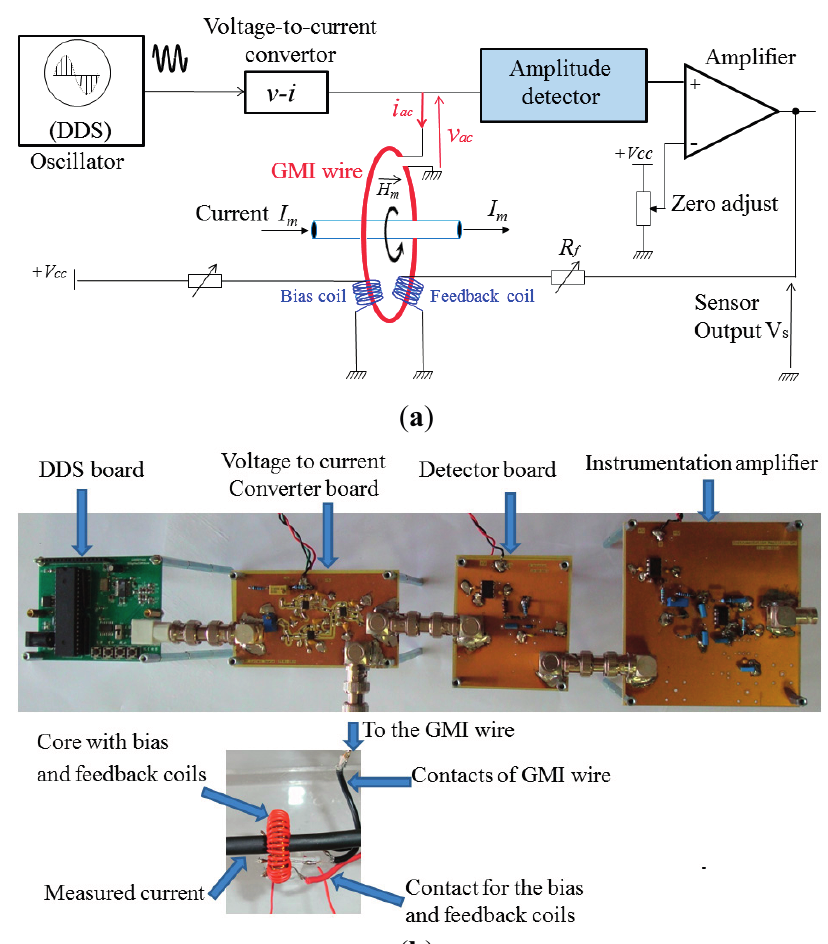
Figure 13. Block diagram of the GMI sensor for the measurement of magnetic fields ( a ) and photo of the setup ( b ). The GMI wire was biased with a magnetic field of about 55 A/m. A 100-turns feedback coil was used. The current I m , which produces the measured field, crosses the